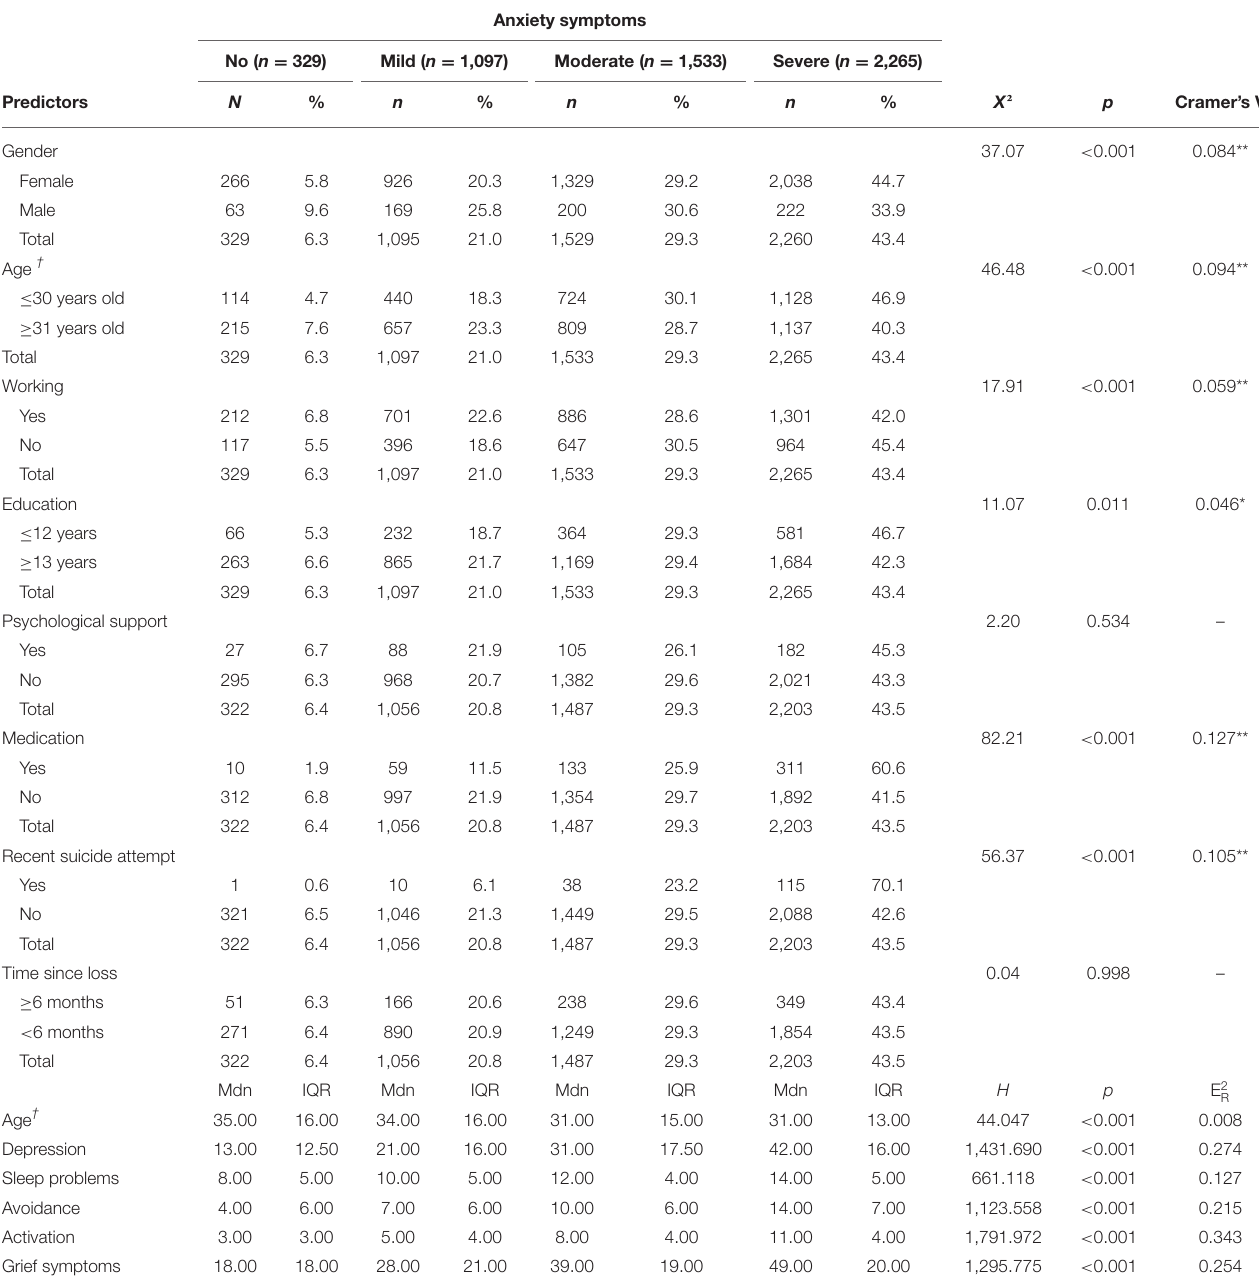
TABLE 3 | Associations between anxiety levels and predictor variables.